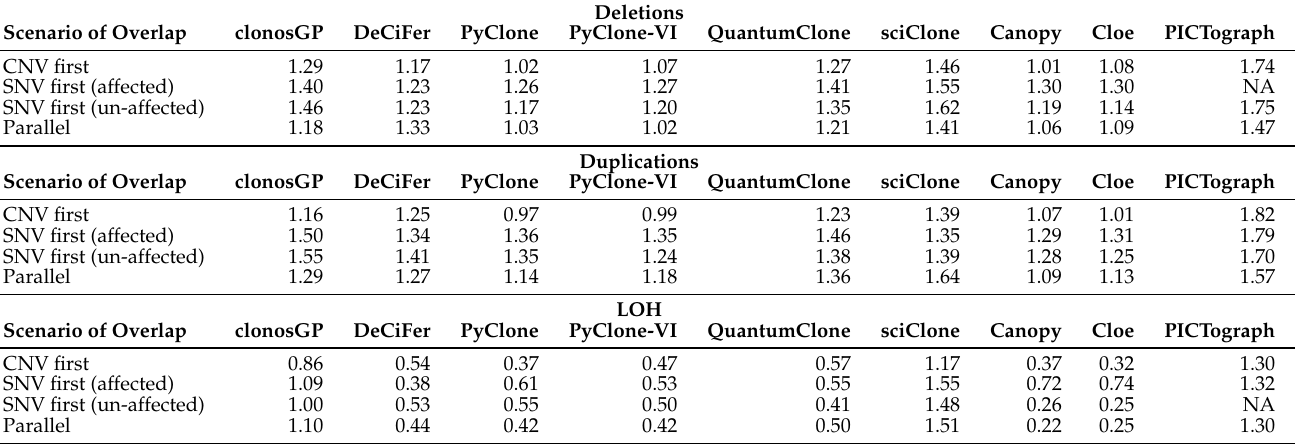
Table A3. Variation of information comparing variant clustering performed using clonosGP, DeCiFer, PyClone, PyClone-VI, QuantumClone, sciClone, Canopy, Cloe, and PICTograph in the presence of CNVs to simulate truth. Deletions, duplications, and LOH were simulated, considering the scenarios of overlap: CNV first, SNV first (affected), SNV first (un-affected), and